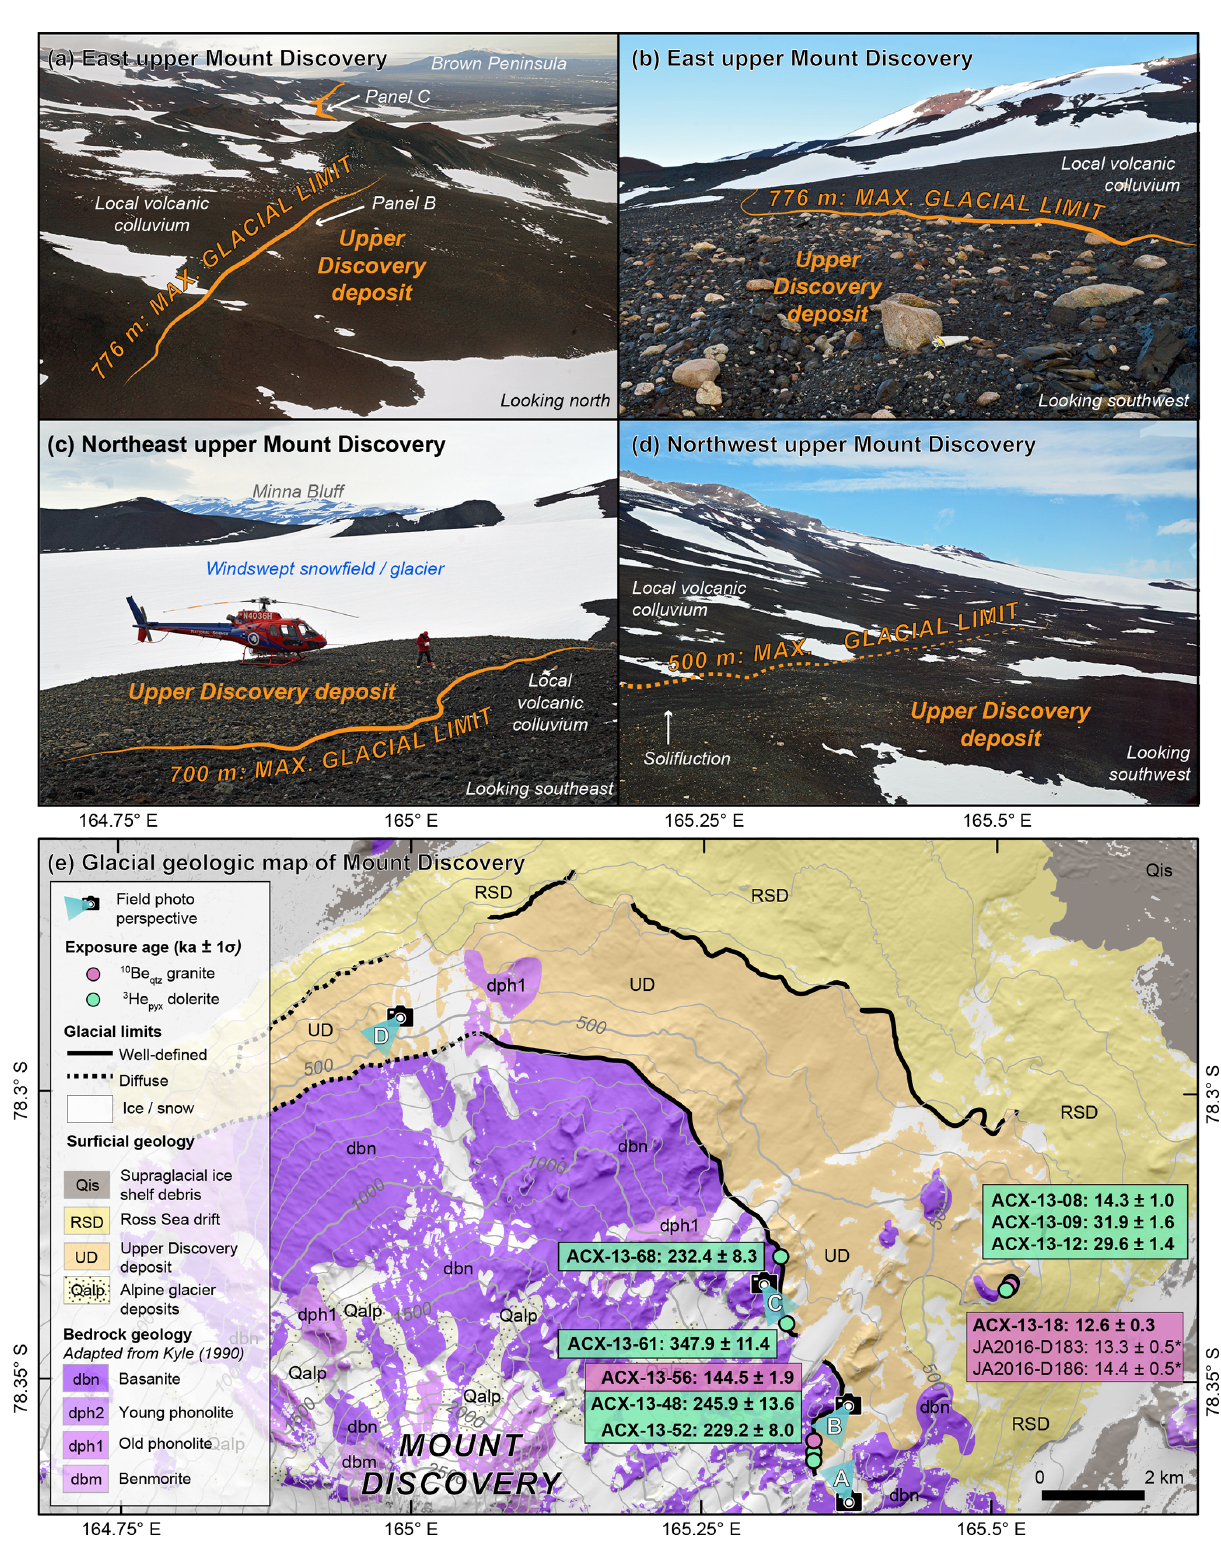
Figure 4. Upper Discovery deposit mapping and exposure ages. (a–d) Field photos show the well-defined (solid orange) and diffuse (dashed orange) glacial limits on upper Mount Discovery. (e) Glacial geologic map and cosmogenic nuclide exposure ages of glacial deposits on Mount Discovery. Camera icon shows vantage point of field photos in panels (a–d) . Samples with “JA2016-” prefix are from Anderson et al., 2017; all other samples are new age constraints from this